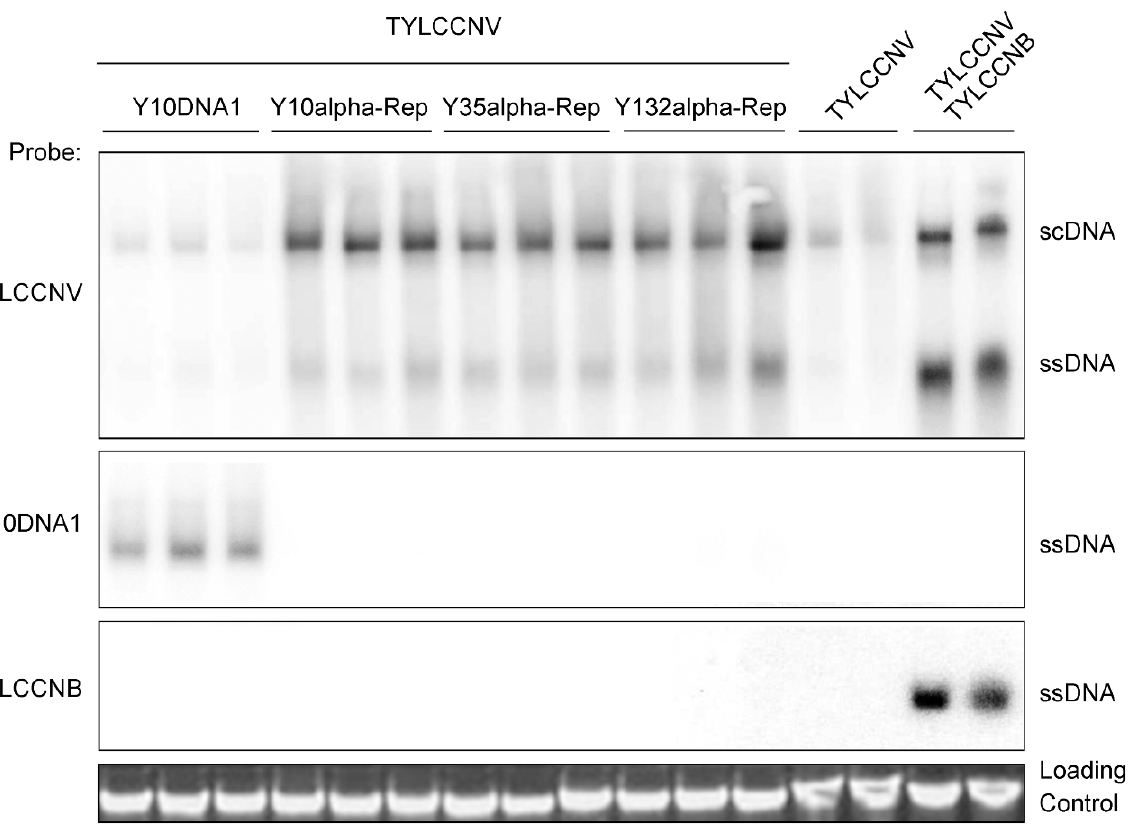
Figure 5. Southern blot analysis of viral DNA accumulation in N. benthamiana plants infected by TYLCCNV alone or together with Y10DNA1, Y10alpha-Rep, Y35alpha-Rep, Y132alpha-Rep, or TYLCCNB at 30 dpi. Total genomic DNA (approximately 10 μg for each lane) from a mixture of three seedlings was used for the Southern blot. Blots were probed with the coat protein gene sequence of TYLCCNV (top), the Rep of Y10DNA1 (middle), and the full-length sequence of TYLCCNB (bottom). An ethidium bromide-stained gel shown below the blots provides a DNA-loading control (downmost). The positions of supercoiled (scDNA) and single stranded (ssDNA) forms are indicated, respectively.